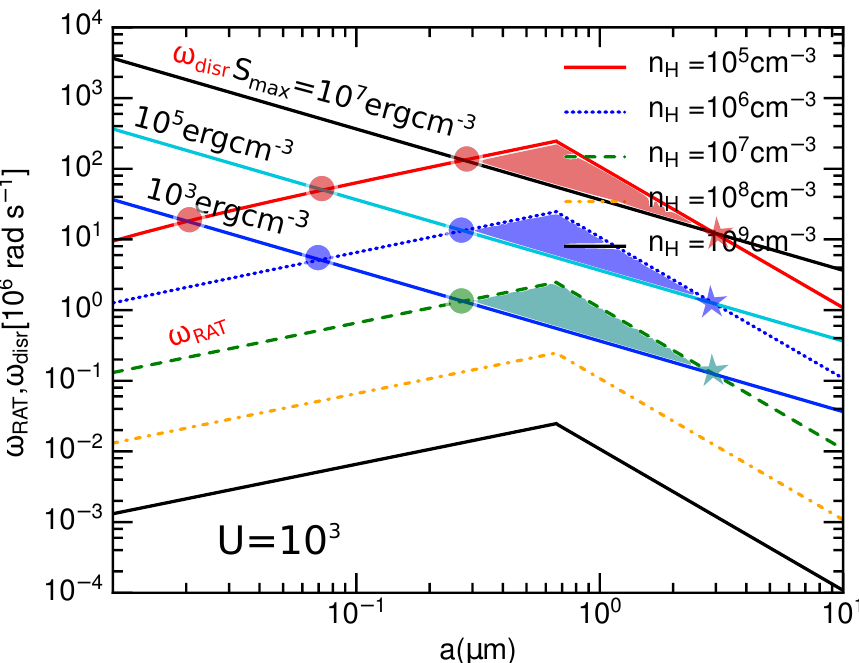
Figure 4. The grain rotation rate spun-up by RATs ( ω RAT ) and disruption rate ( ω disr ) as functions of the grain size for different gas densities. The radiation strength U = 10 3 and three values of tensile strengths S max = 10 3 ,10 5 ,10 7 ergcm − 3 are considered. The peak of ω RAT occurs at a = a trans . The intersection of ω RAT and ω disr can occur at a lower grain size (marked by a circle) and an upper size (marked by a star), and the shaded area denotes the range of grain sizes in which grains are disrupted by